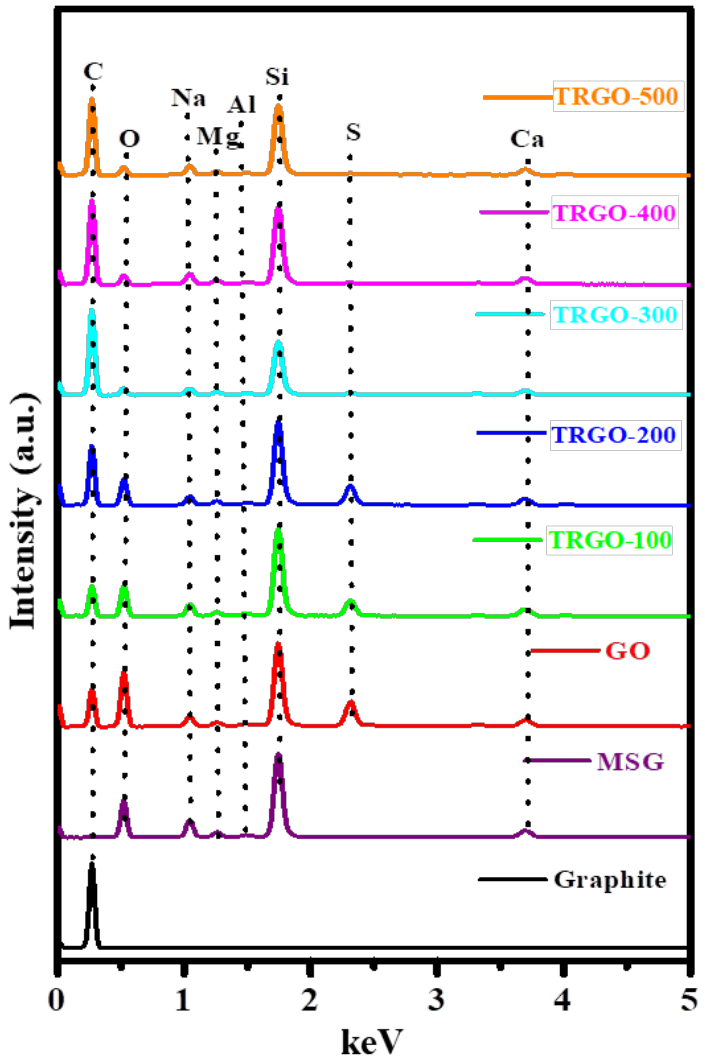
Figure 3. EDS spectrum of graphite, MSG, GO, and TRGO samples.